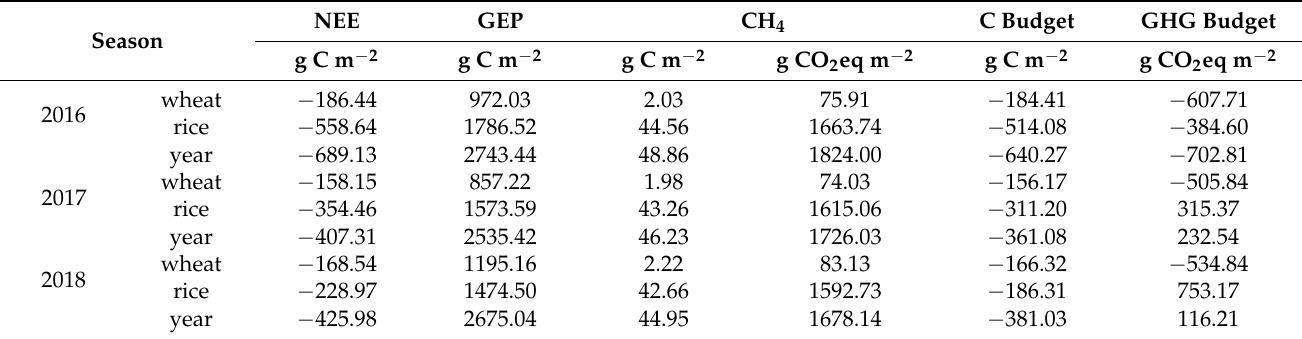
Table 4. Annual sums of net CO 2 fluxes, GEP, CH 4 fluxes, total ecosystem carbon (C) and greenhouse gas (GHG) budgets in wheat and rice season were estimated. The total C and GHG budget for one year were also calculated.